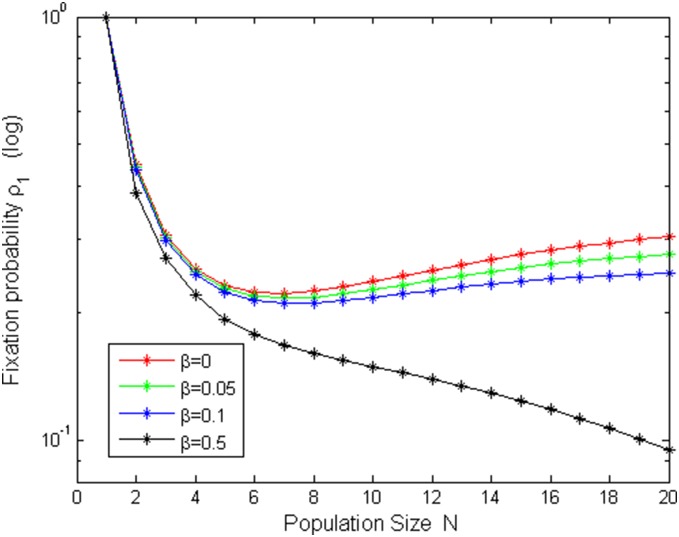
ρ1 vs N with µ = 0.95, b = 1.2 and different β values.